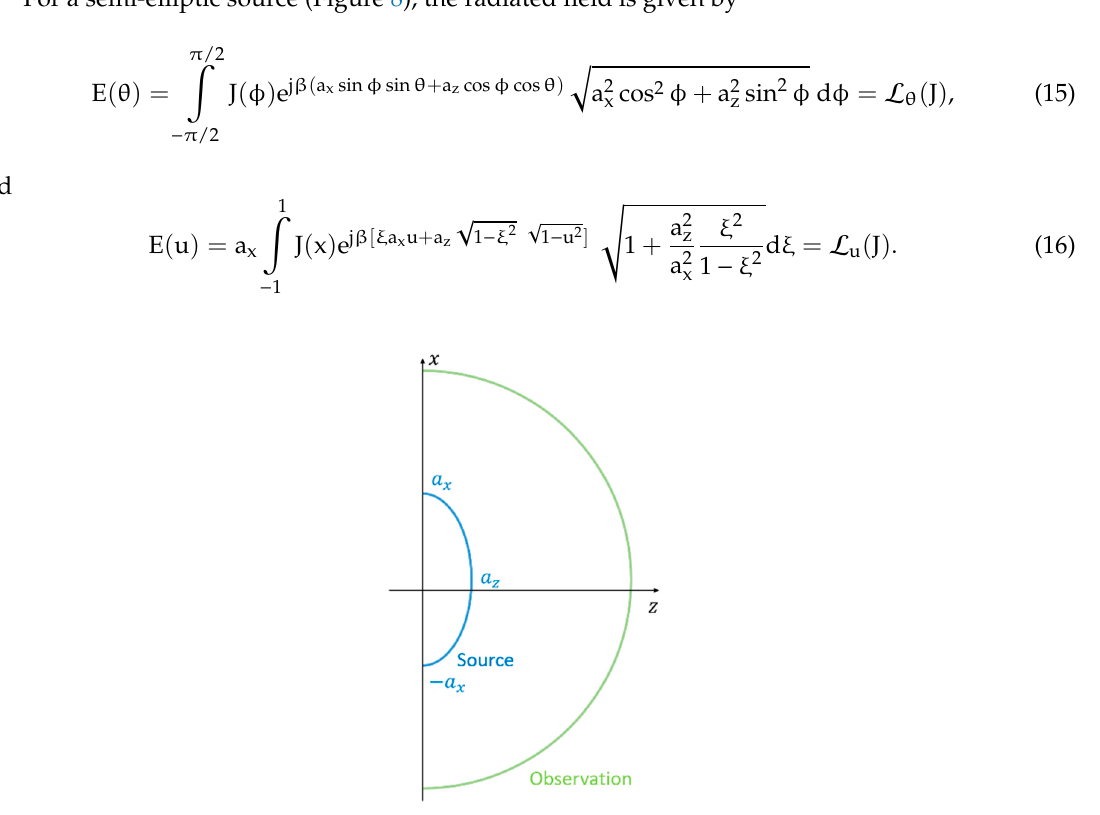
Figure 8. Semi-elliptic source geometry.